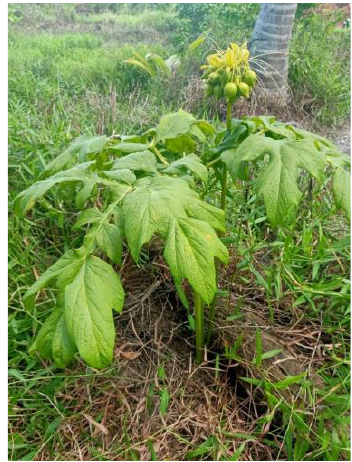
Figure 1. Tacca Plant (T. leontopetaloides) . Table 1. Taxonomic Classification of Tacca Plant.